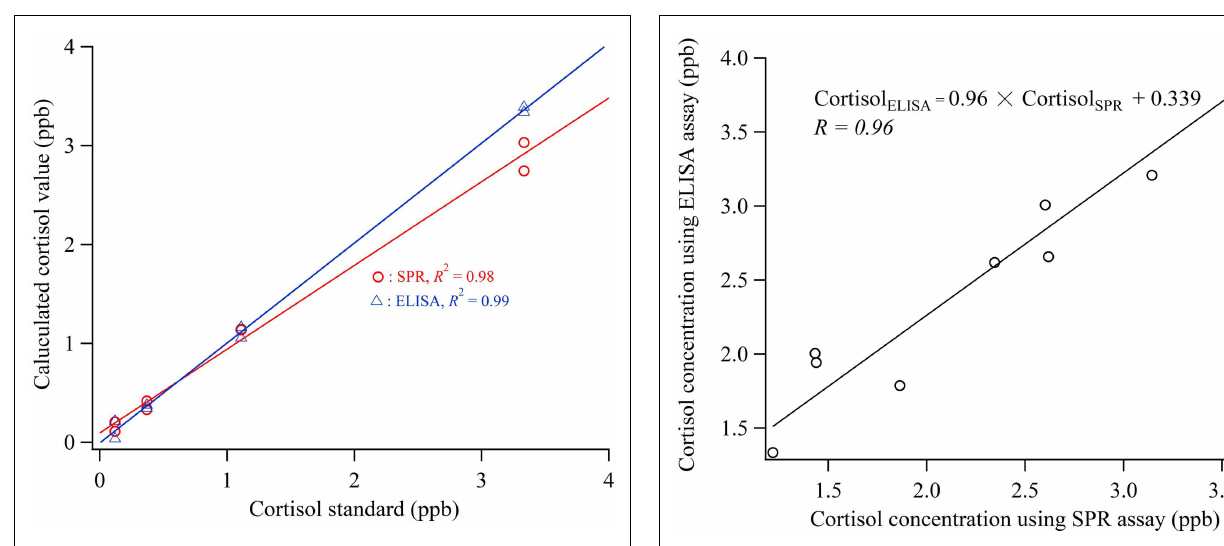
FIGURE 5 | Comparison of the measurement values obtained with cortisol biosensor and ELISA using human saliva samples